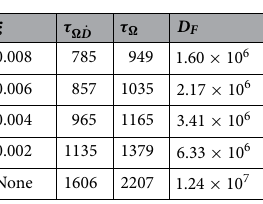
Table 3. Viral extinction dates and total fatalities as a function of vaccination rapidity, for the scenarios shown in Fig.